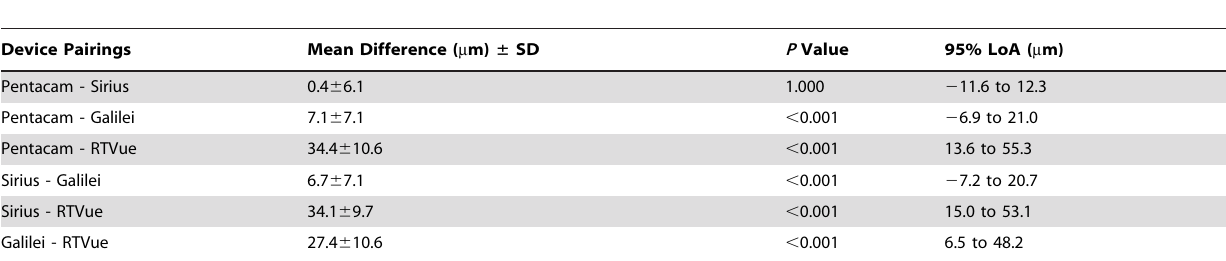
Table 5. Mean difference of superior 5 mm corneal thickness, corresponding results of Bonferroni post hoc comparison and 95% limits of agreement (LoA) among the 4 investigated devices.